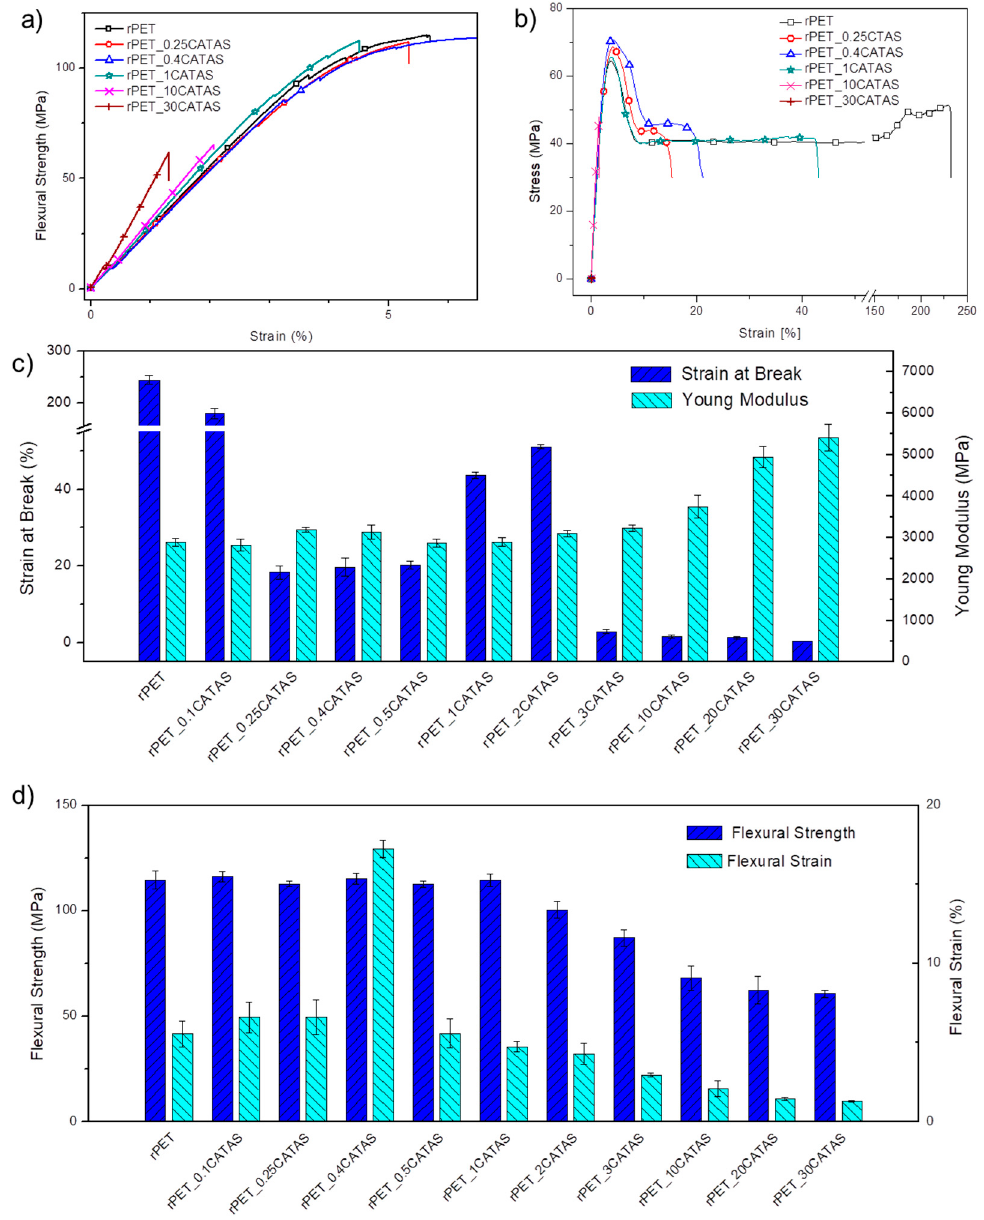
Figure 4. Stress-strain curves from flexural ( a ) and tensile tests ( b ), variation of tensile modulus and strain at break ( c ), variation of flexural stress and strain ( d ) for rPET_CATAS nanocomposites at the different loading levels .